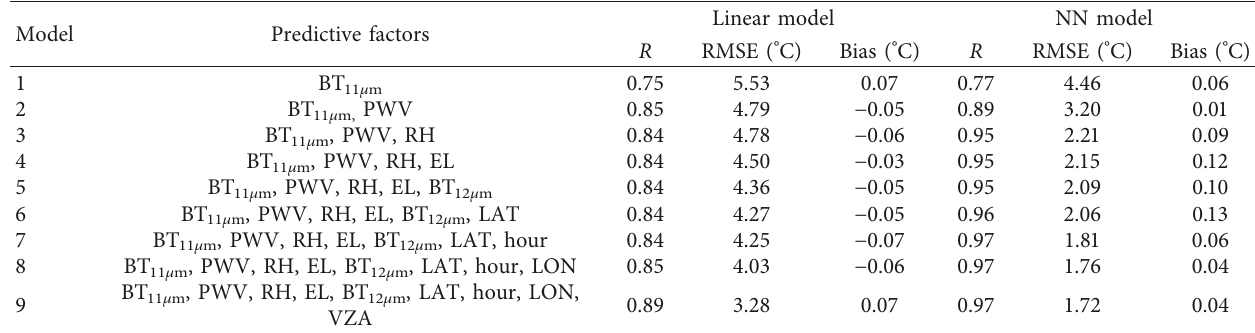
Table 4: Statistical results for T air estimation by linear and NN